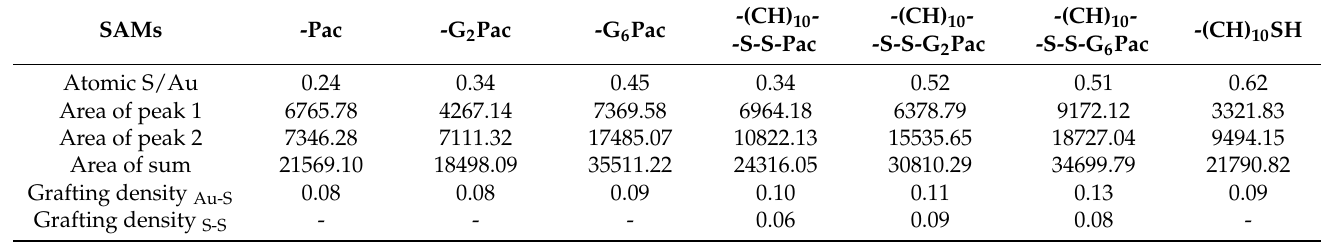
Table 2. The analysis of XPS peak of different SAMs.